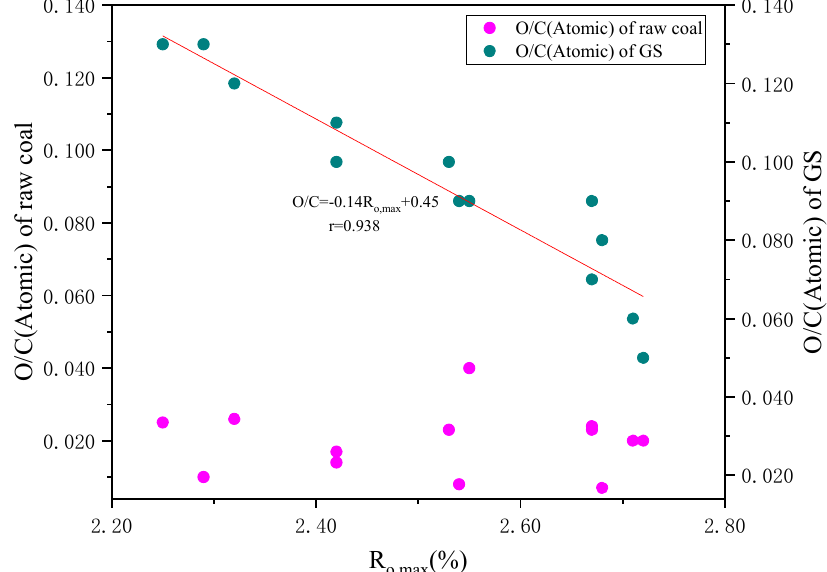
Figure 15. Scatter diagram of O/C of raw coal and coal-based GS.